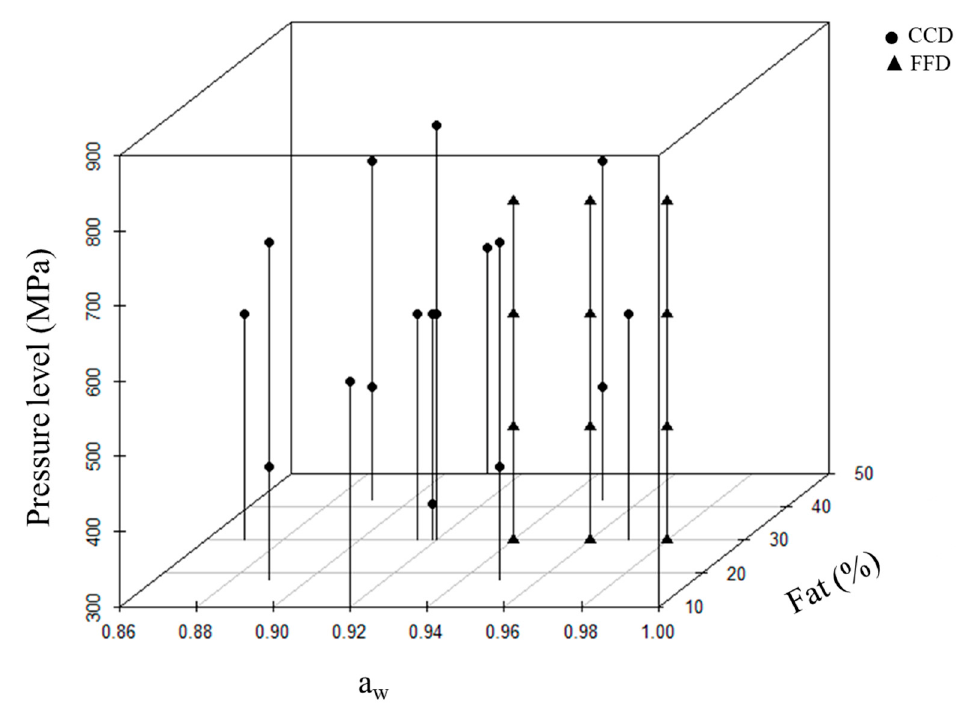
Figure 1. Scatterplot showing the a w and fat content of the dry-cured ham (DCH) and pressure levels included in the experimental conditions of the central composite design (CCD) and the full factorial design (FFD).